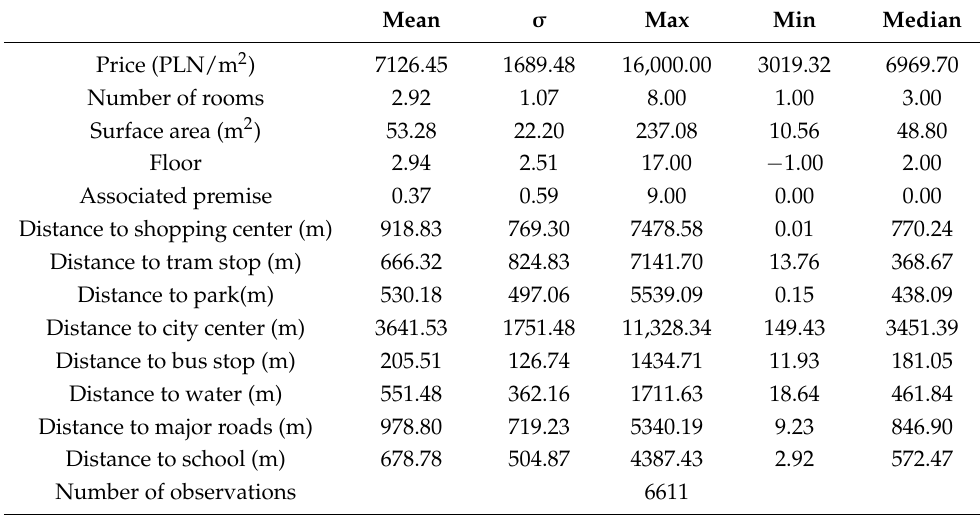
Table 2. Descriptive statistics of dependent and independent